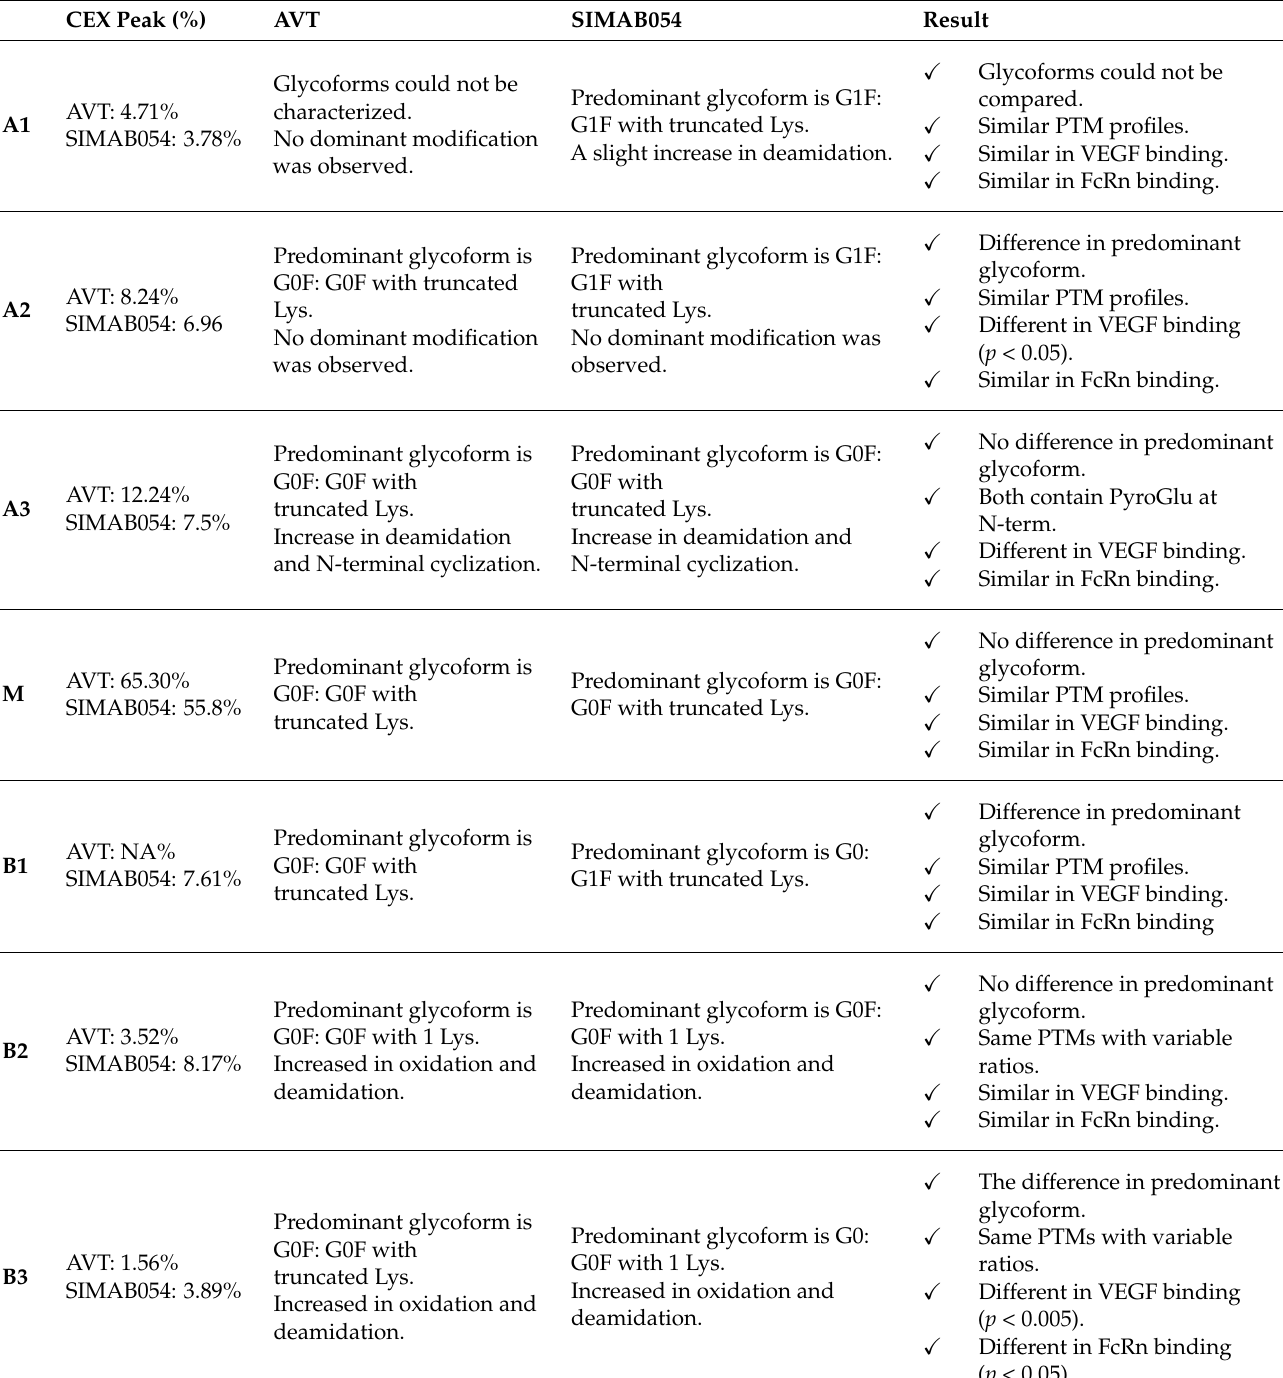
Table 2. A summary of the results obtained by chemical and biological activity characterization studies was